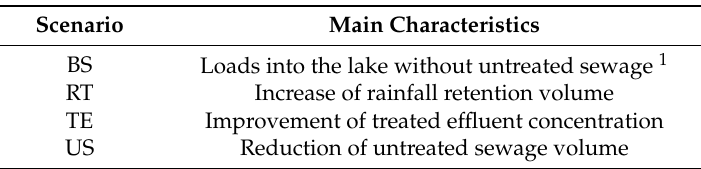
Table 1. Load reduction scenario definitions.